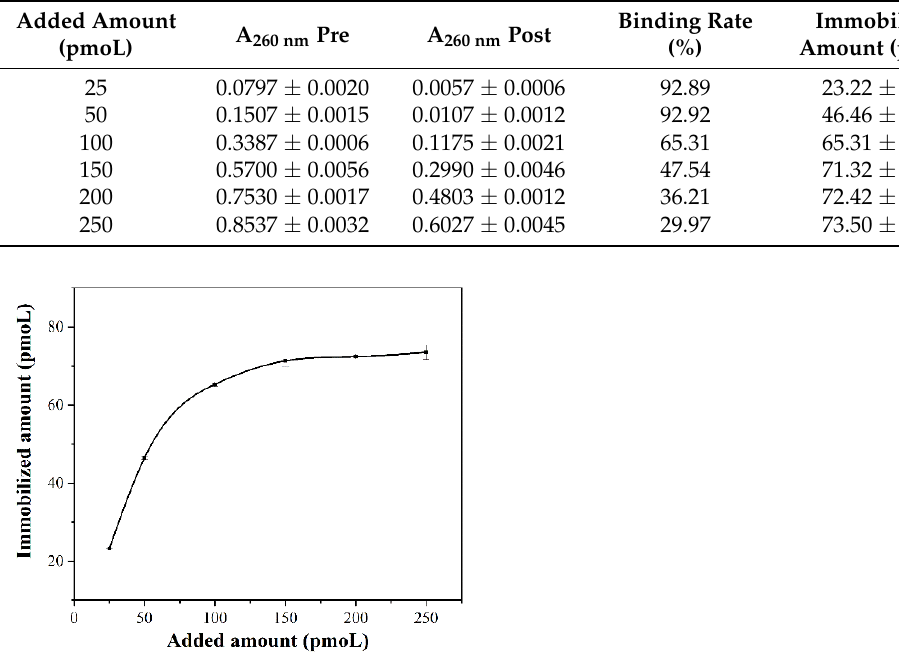
Figure 2. Determination of the optimal immobilized amount of biotin probes on the surface of the magnetic particles. Table 2. The absorbance value of biotin-probe solution before and after binding to the magnetic particle.